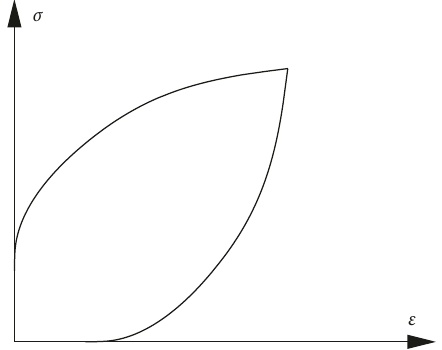
Figure 6: Stress-strain curve of nonlinear